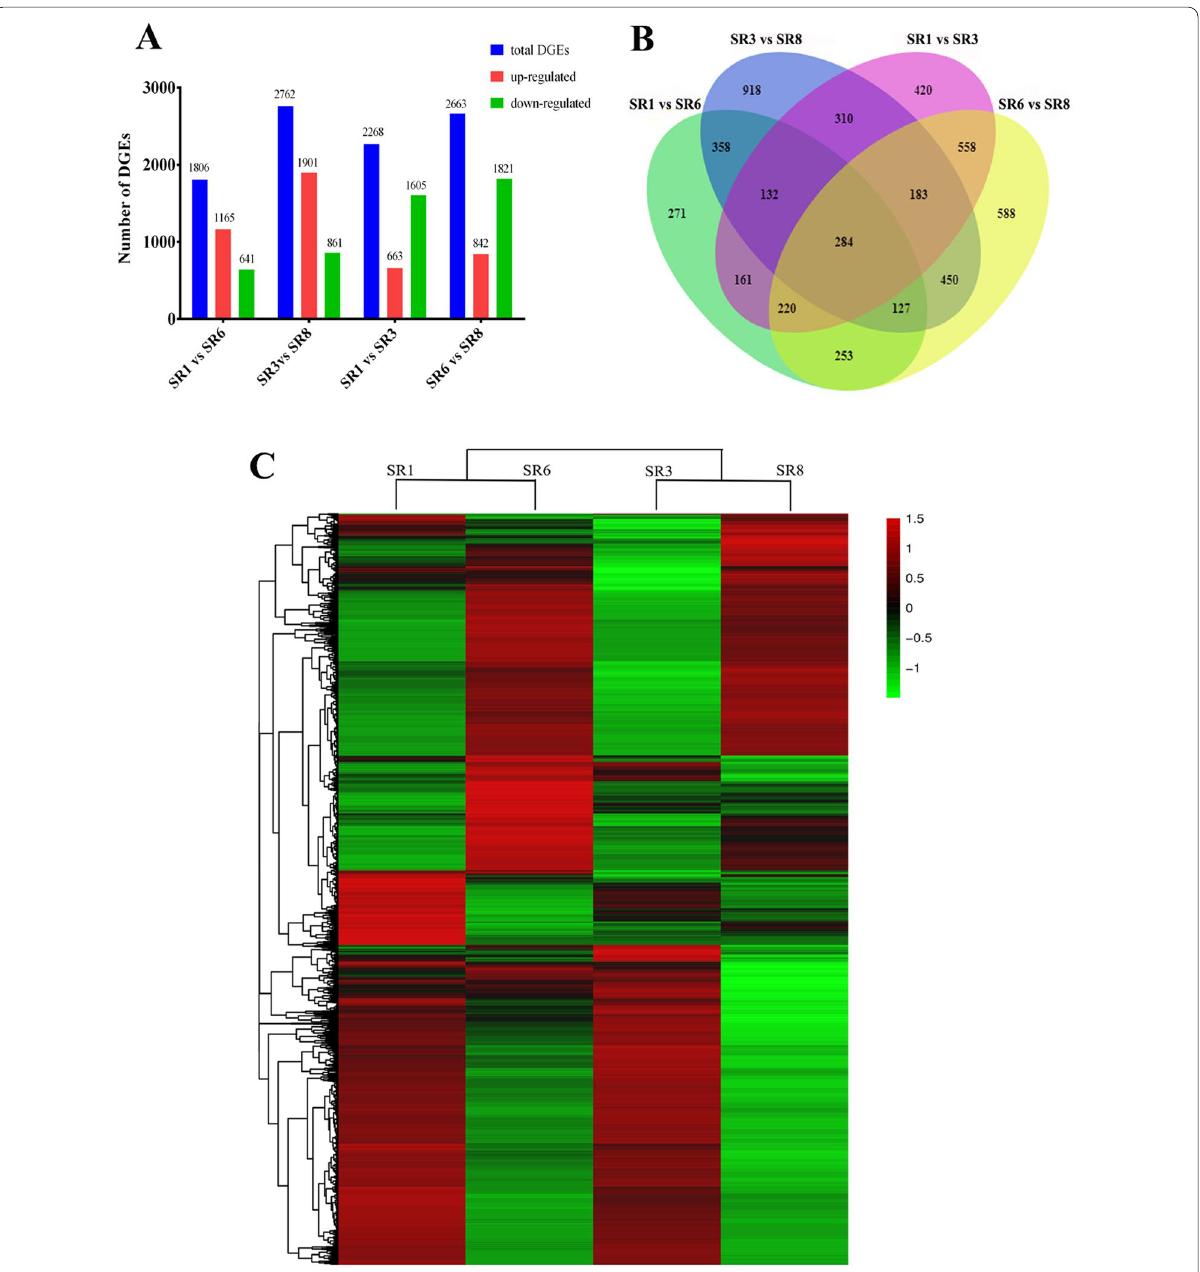
Fig. 2 Statistic of different expressed genes. A Number of differentially expressed genes (DEGs) after the temperature treatments. B Venn diagram of DEGs among the different comparisons. C Heat map showing the expression level of